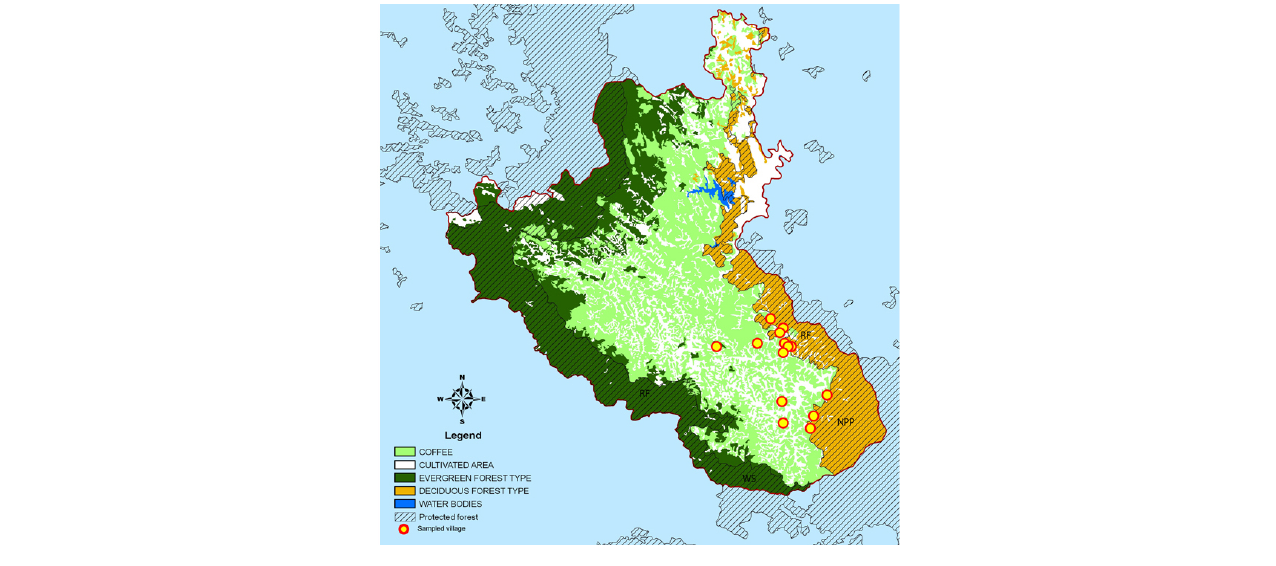
Fig. 1. Study area. The map shows the location of the study villages (circles) in the district of Kodagu (Karnataka), the vegetation cover obtained from remote sensing, and the boundaries of the state controlled forests (WS = Wildlife Sanctuary, NNP = Nagarahole National Park, and RF = Reserved Forests). Source: K. M. Nanaya, French Institute of